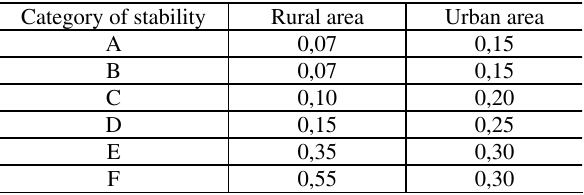
Table 1 . Values of p depending on the category of stability Category of stability Rural area Urban